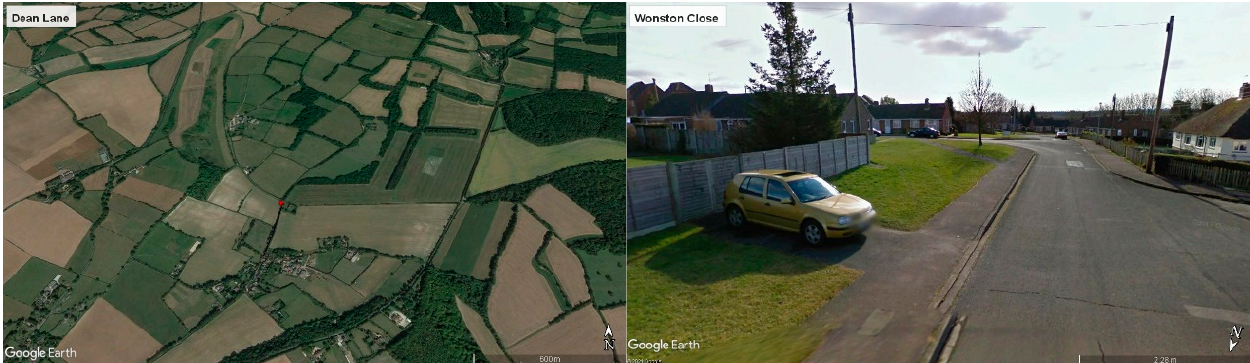
Figure 9. Dean Lane ( left ) was excluded from further analysis as it was too far (1 mile radius) from a significantly populated area, while Wonston Close ( right ) is an example of a suitable location for installing an EV charging point.